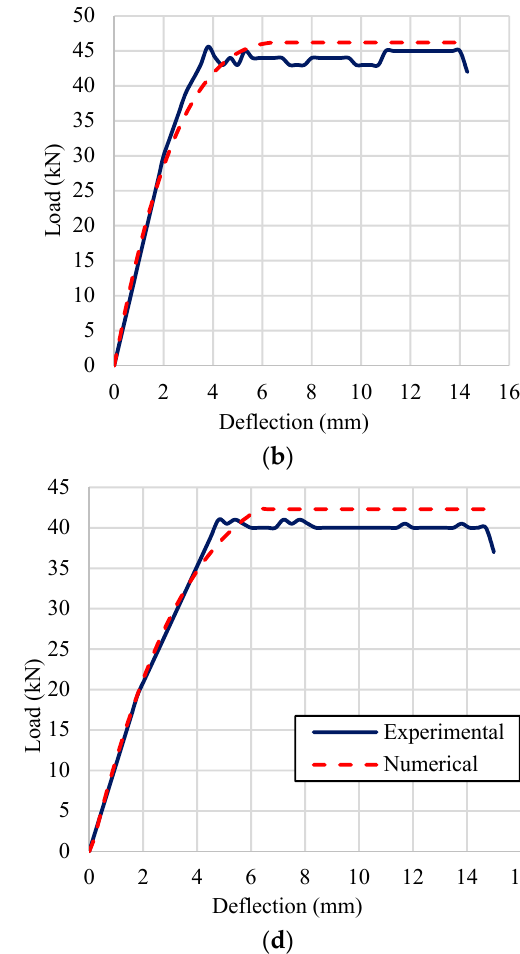
12 of 16 Table 4. Comparison between experimental and numerical results. Beam